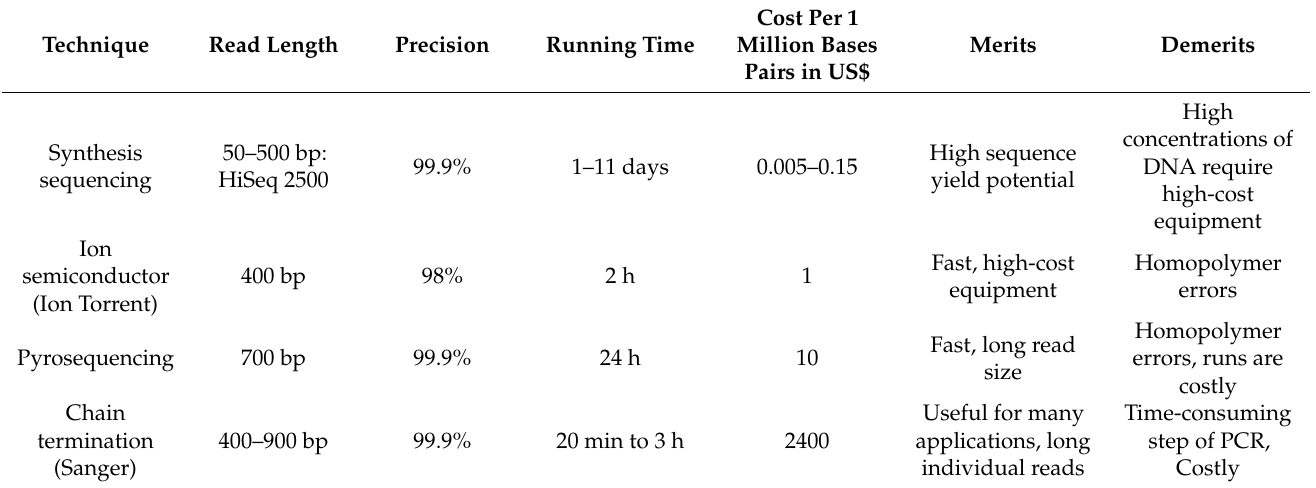
Table 1. Comparison of selective high-throughput sequencing methods. Adapted from Raju & Scalvenzi